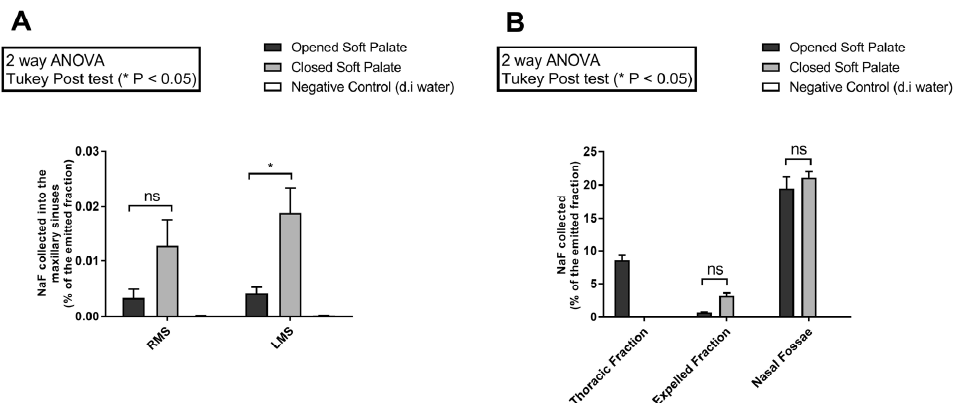
Figure 2. Comparison of results obtained for the NaF deposition with opened or closed soft palate for the PARI SINUS device. ( A ) Maxillary sinus deposition (RMS = right maxillary sinus; LMS = left maxillary sinus). ( B ) Amount of NaF collected in the thoracic fraction (only for opened soft palate condition), in the expelled fraction, and in the nasal fossae. Results are expressed in percentage of the emitted fraction. Negative control corresponds to deionized water (d.i water) nebulization. Statistically different from control cells: * p < 0.05.